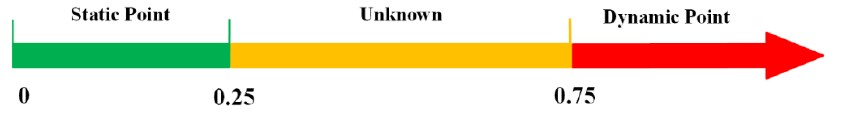
project M is the set of